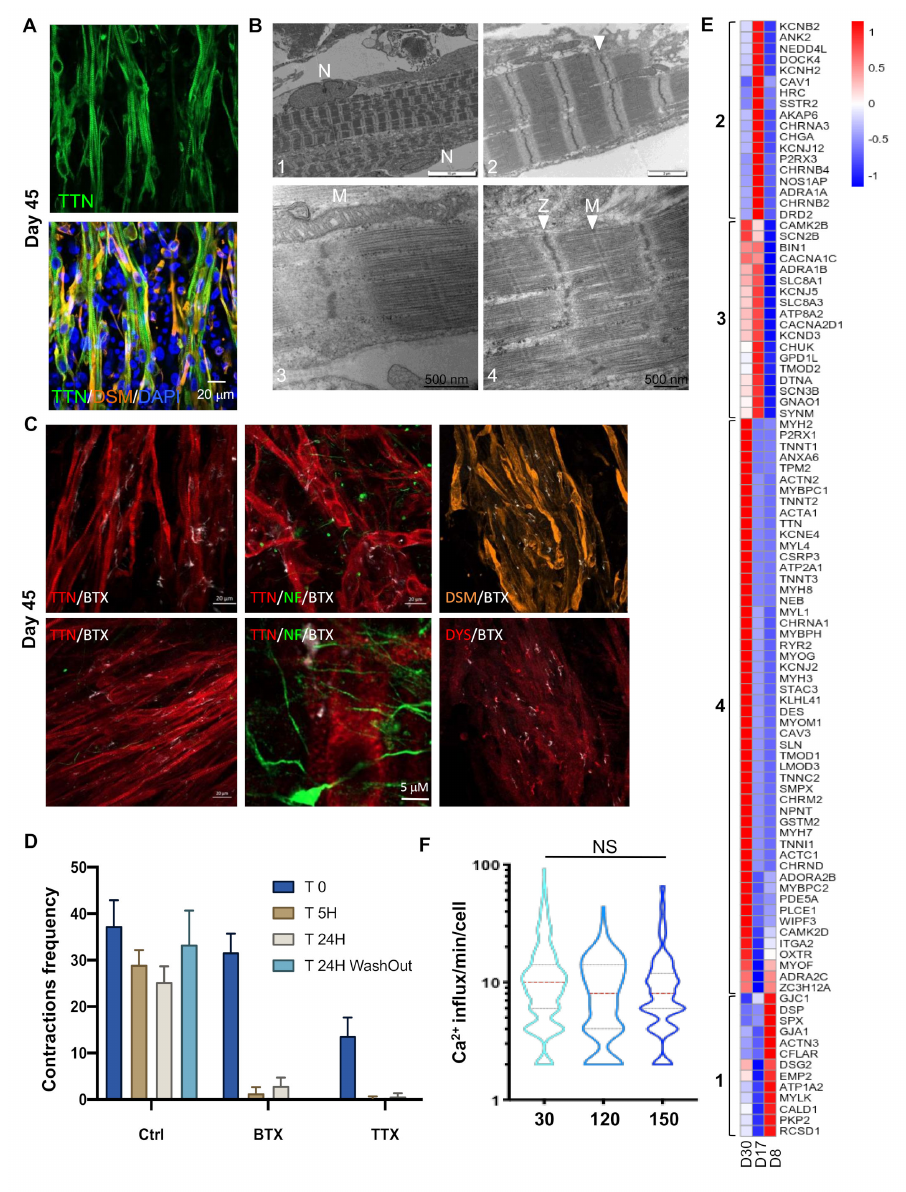
Figure 2. Ultrastructural and functional validation of hiPSC-derived myofibers. ( A ) Representative Z stacks of muscle fibers at Day 30, stained for Titin (TTN, green, upper panel) and merged between Desmin (DES, orange) and Titin filament (green, lower panel) at Day 30 postdifferentiation. Nuclei